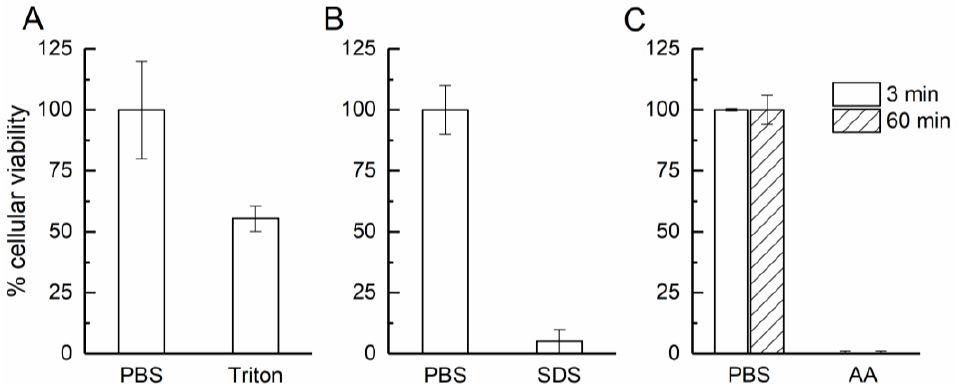
Figure 3. Cellular viability accessed in permeability ( A ), irritation ( B ), and corrosion ( C ) tests. PBS was used as control; Triton: 0,1% Triton X-100; SDS: 5% SDS; AA: acetic acid (glacial). For functional irritation response, the cEpiderm slices were exposed on the apical side to 5% SDS. The negatively charged detergent induced a loss of cell viability of 95% compared to controls (Figure 3B). Histological evaluation of the biopsies revealed that SDS acted by disrupting the structure of cEpiderm patches, causing detachments of the keratinocytes (Figure 4, upper panel).